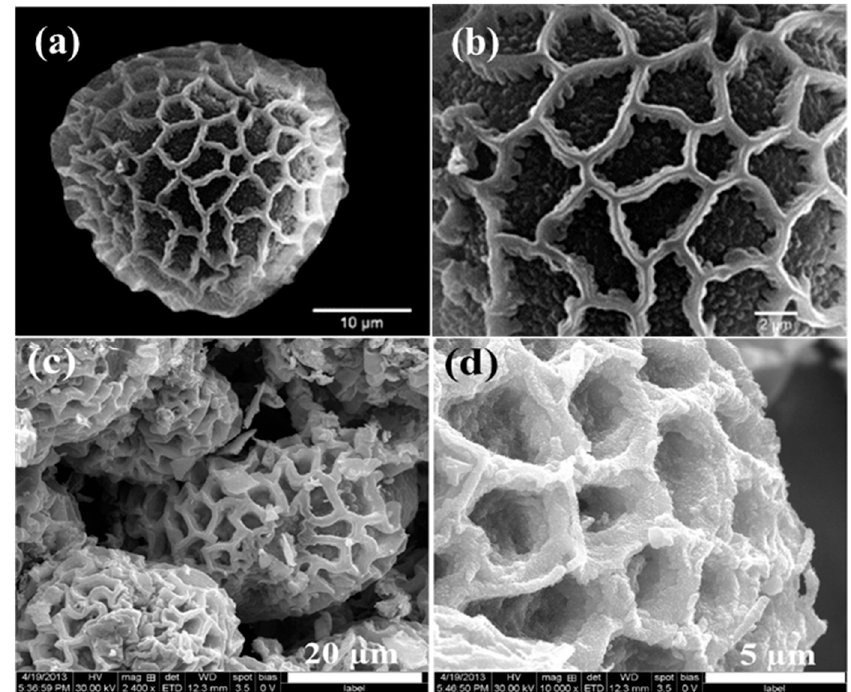
Figure 1. ( a , b ) are SEM images of Balsaminaceae pollen with a microscale porous network and nanoscale structures on the surface [2]; ( c , d ) are SEM images of constructed SnO 2 structures for gas sensing created using Peltophorum pterocarpum pollen grains as a template [3] .